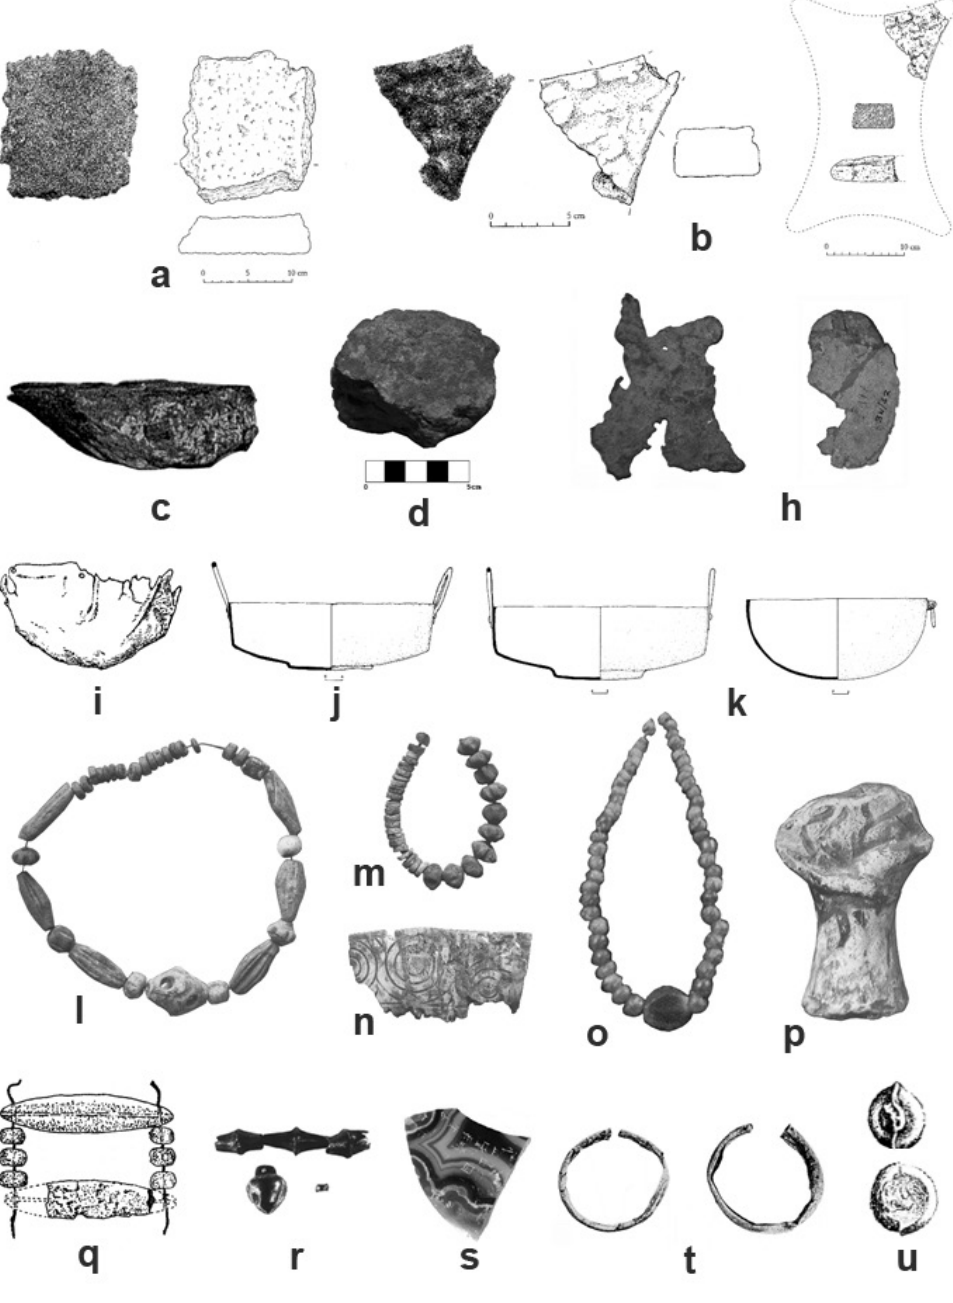
Figure 5: a) Ox hide ingot from Thapsos (Lo Schiavo et al., 2009); b) Ox hide ingot from Lipari hoard (Lo Schiavo et al., 2009); c) Ingot from off shore Cefalù (Purpura, 1975); d) Copper ingot from Għar Mirdum (Tanasi et al., 2019); h) Fragment of bronze and lead vessels from Borġ in-Nadur temple ( Tanasi et al., 2019); i) Metal basin from tomb 57 of Thapsos (Tanasi, 2010b); j) Metal basin from Tholos B of Monte Campanella di Milena (Tanasi, 2010b); k) Metal basins from Monte San Vincenzo di Caldare (Tanasi, 2010b); l) Glass beads necklace from tomb 48 of Plemmirio (Voza, 1985); m) Amber beads jewel from tomb D of Thapsos (after Voza, 1985); n) Ivory comb from tomb. 48 of Plemmirio (after Voza, 1985); o) Semi-precious stone necklace from Hut F of Portella di Salina (Martinelli, 2005); p) Late Helladic IIIA Proto- phi terracotta idol from Lipari (after Voza, 1985); q) Amber spacer beads from tomb 10 of Plemmirio (Cornaggia Castiglioni & Calegari, 1978); r) Golden jewel elements from tomb D of Thapsos (Militello, 2004); s) Agate crescent from Tas-Silġ South (Mayer, 2012); t) Bronze earrings with golden coating from Borġ in-Nadur temple (Tanasi, 2018); u) Bronze disks from tomb 14 of Thapsos (Orsi,